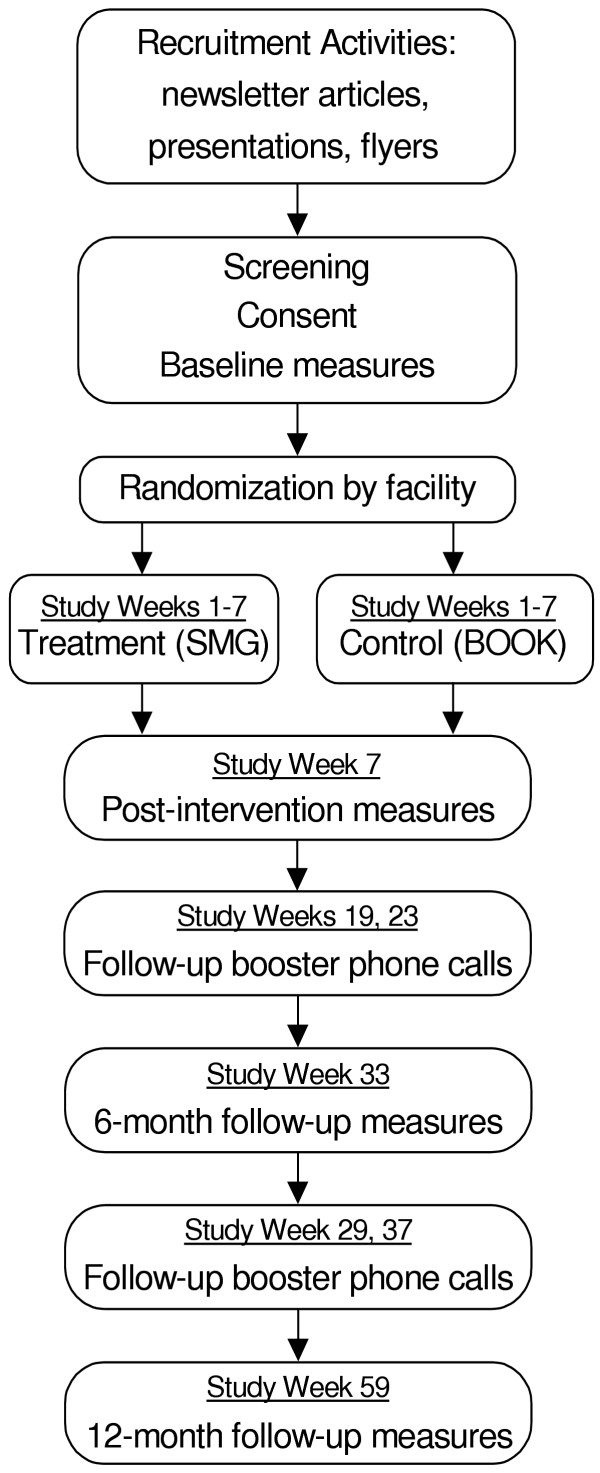
Study flowchart